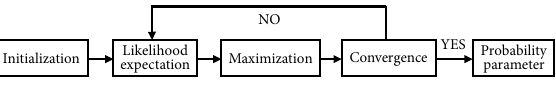
Fig. 4. Flow of EM